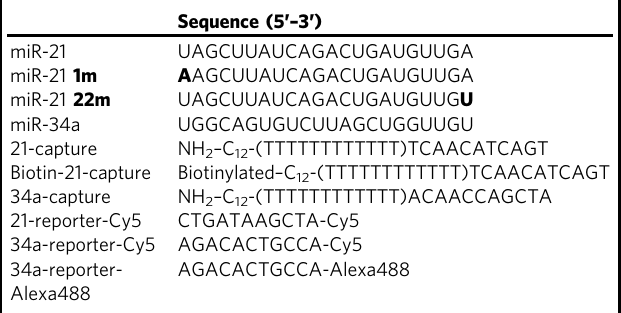
Table 1 Synthetic miRNA sequences including one mismatch single base (highlighted in bold) and oligonucleotide sequences used for miR-21 and miR-34a detection